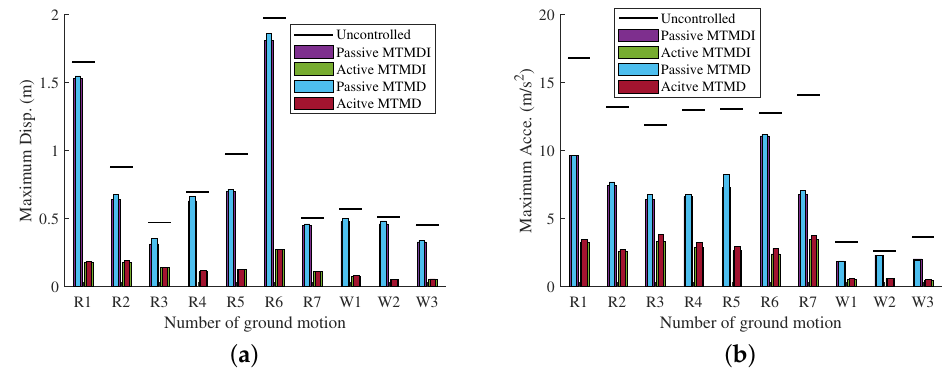
Figure 19. The maximum response of the top of the main structure before being damaged: ( a ) The maximum relative displacement and ( b ) The maximum absolute acceleration.